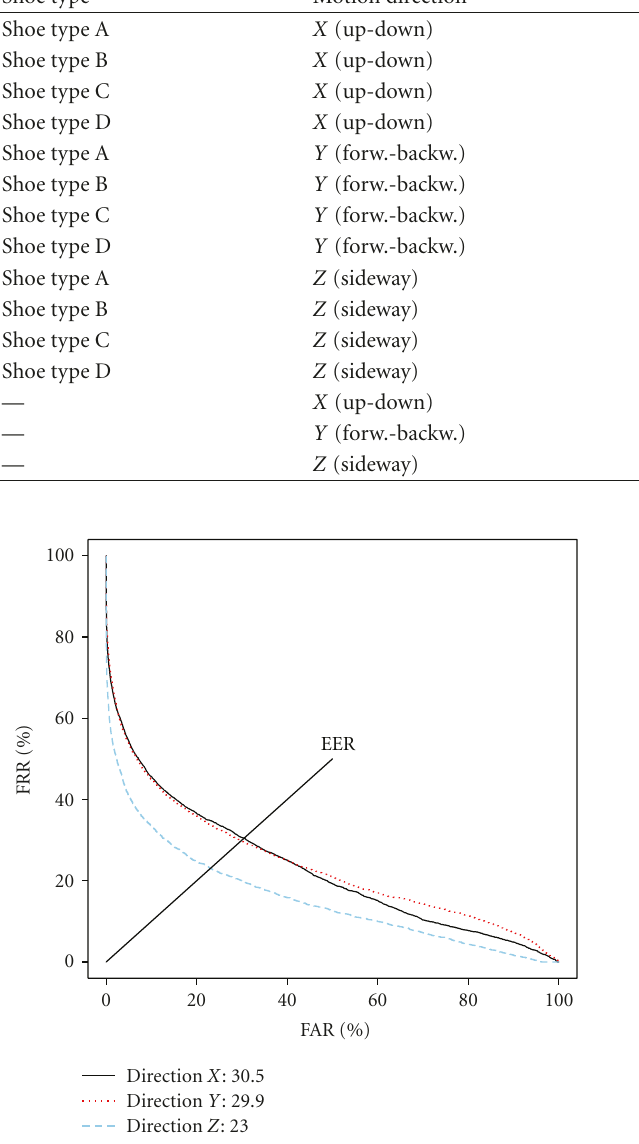
Figure 11: Authentication regardless of the shoe types.